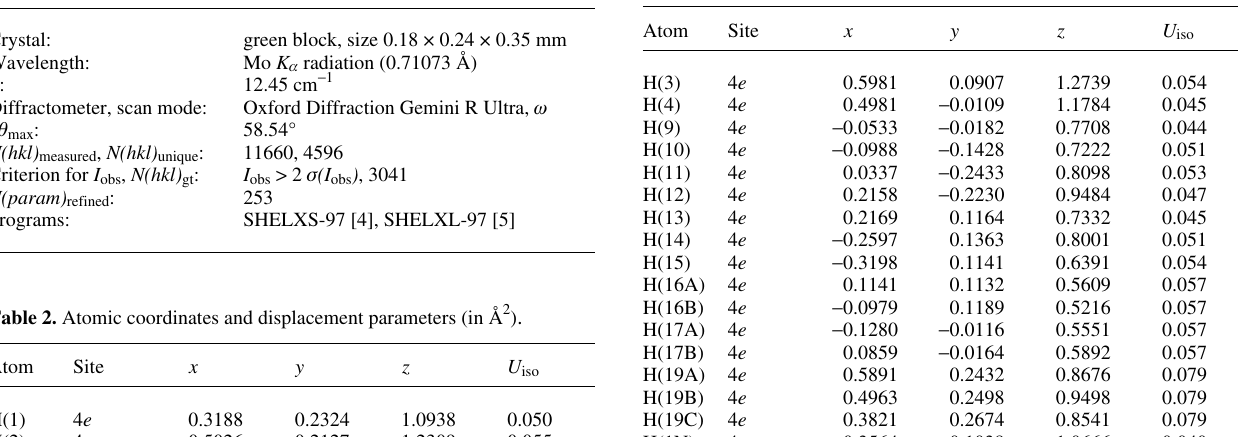
Table 1. Data collection and